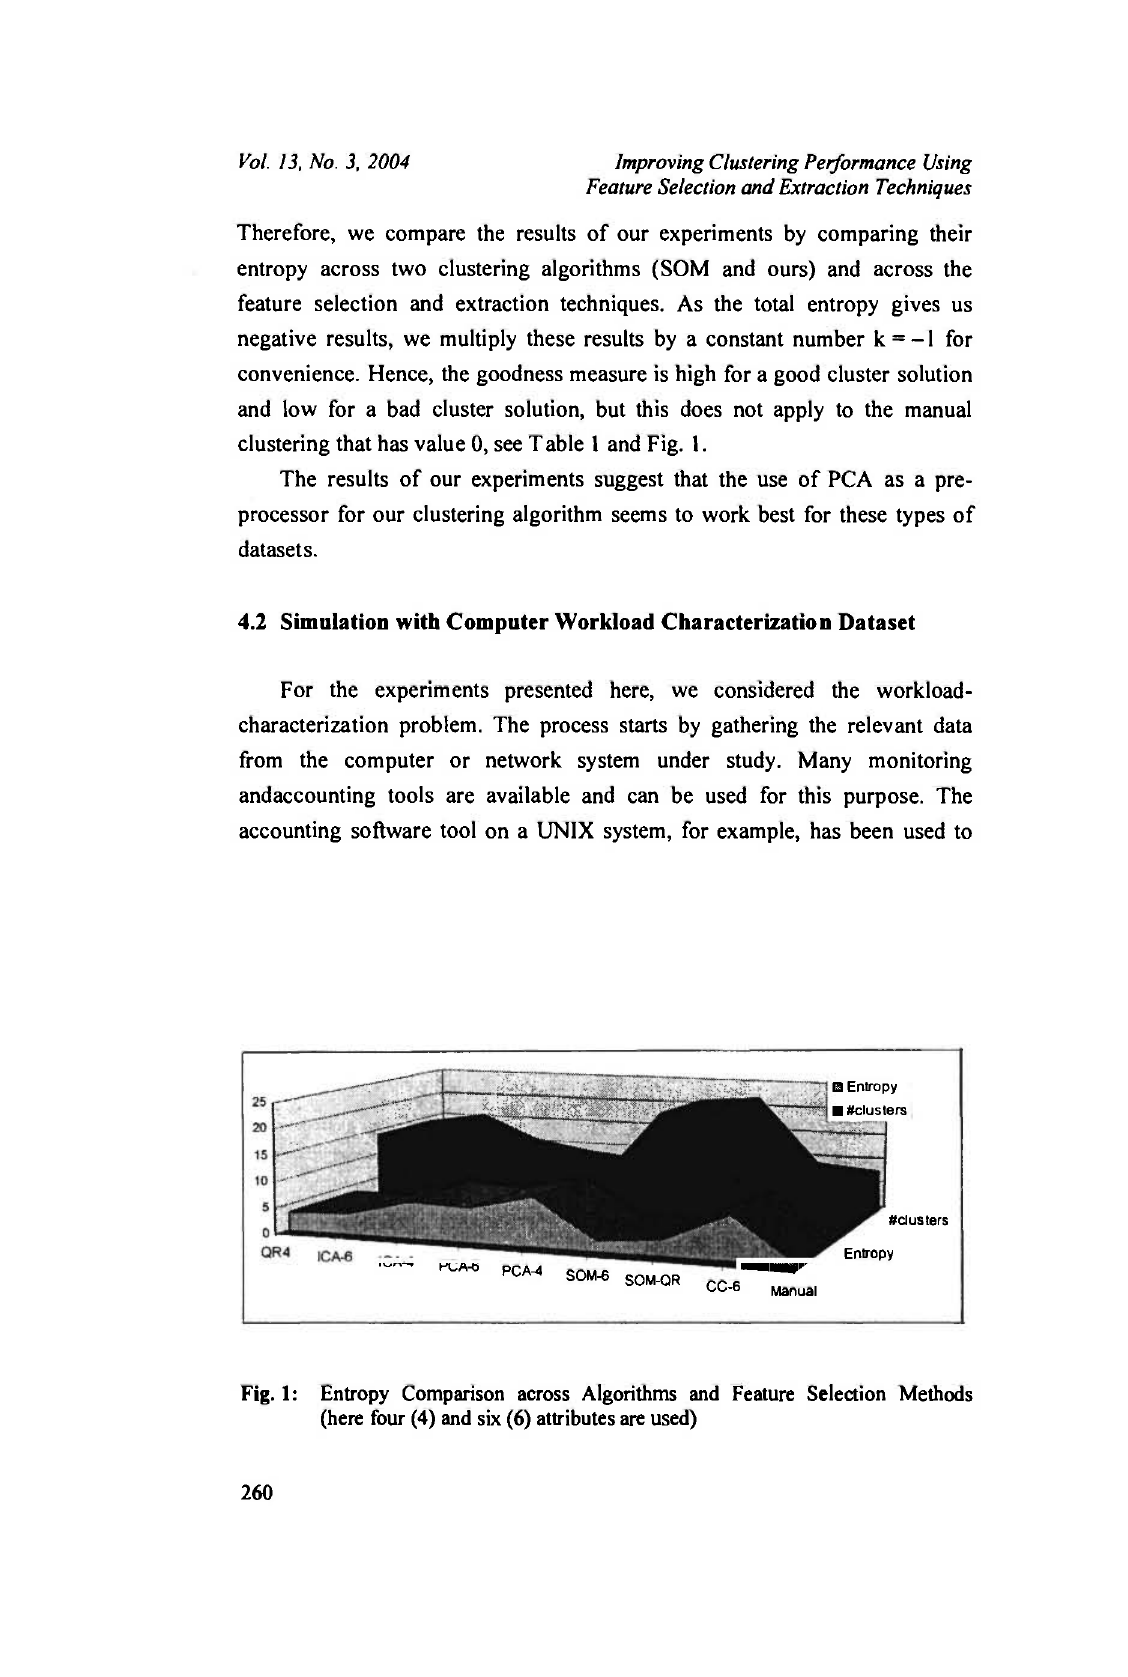
Fig. 1: Entropy Comparison across Algorithms and Feature Selection Methods (here four (4) and six (6) attributes are used)